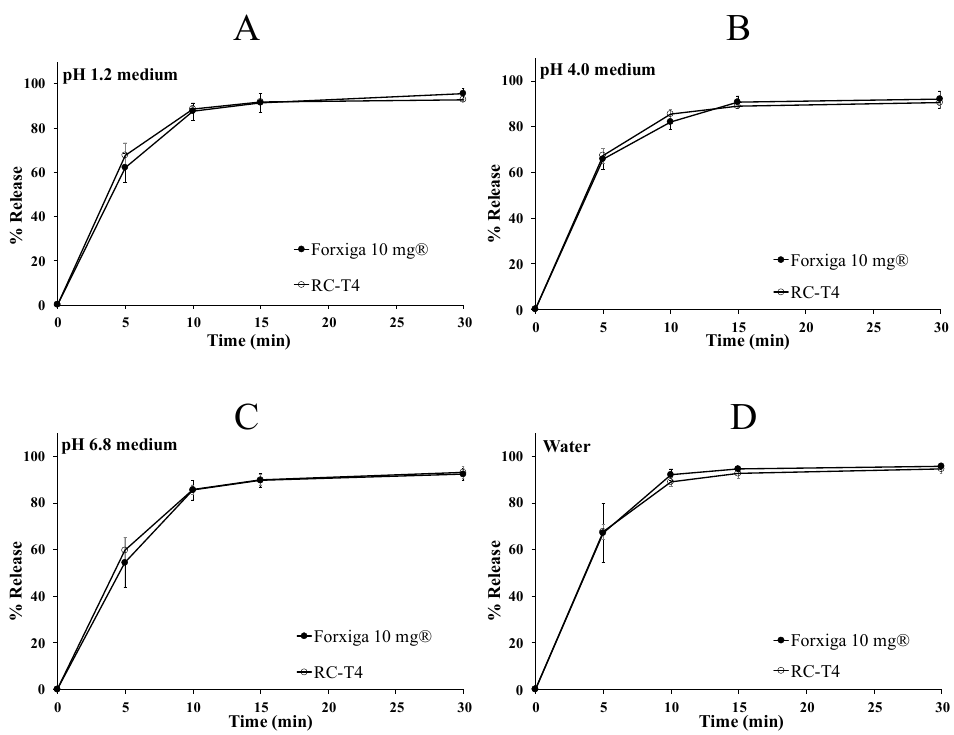
Figure 3. Dapagliflozin (DAP) dissolution profiles from Forxiga ® 10 mg and RC-T4 in pH 1.2 ( A ), pH 4.0 ( B ), pH 6.8 ( C ), and distilled water ( D ). The experiment was conducted in USP Apparatus 1 at 50 rpm and in dissolution media at 37.0 °C. Each value represents the mean ± standard deviation ( n = 6).